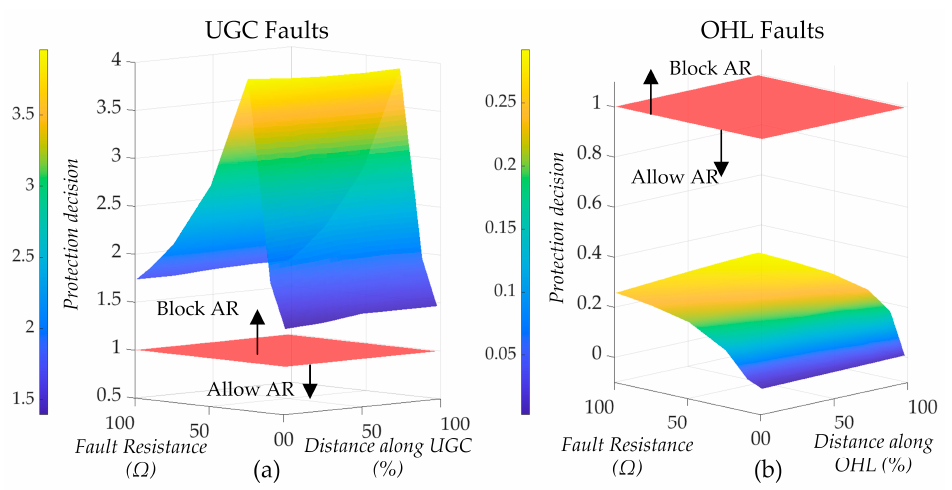
Figure 7. Performance of the proposed scheme with UGC sheath cross-bonding; ( a ) faults on the UGC section, ( b ) faults on OHL sections .